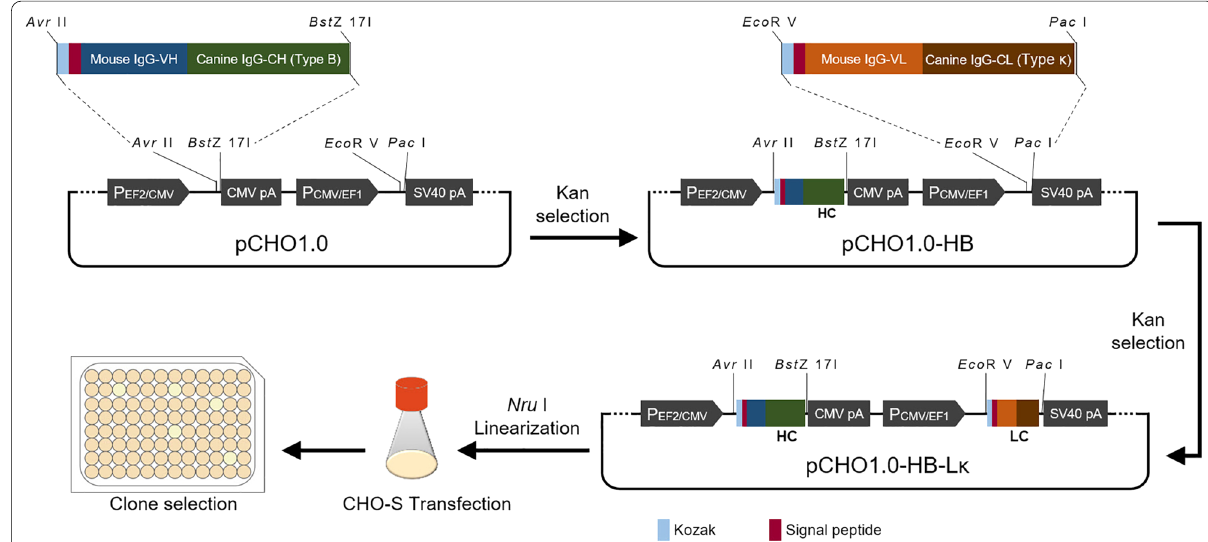
Fig. 1 Schematic design of the chimeric antibody